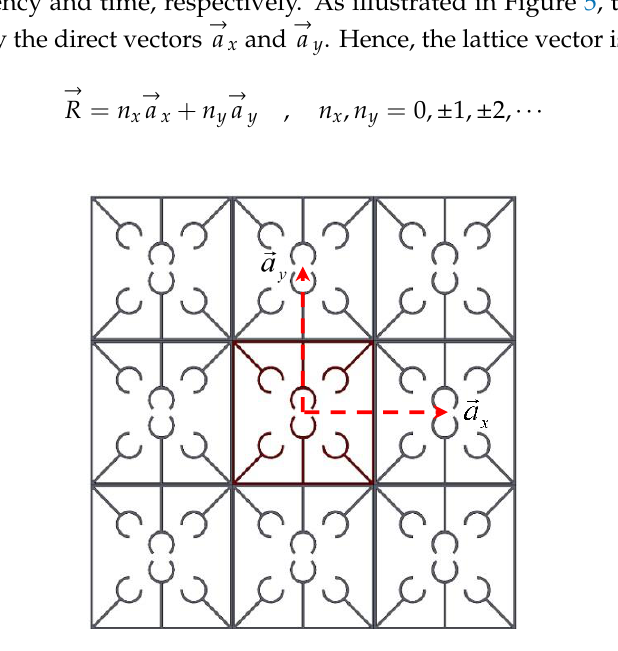
Figure 5. Direct vectors in a periodic model.